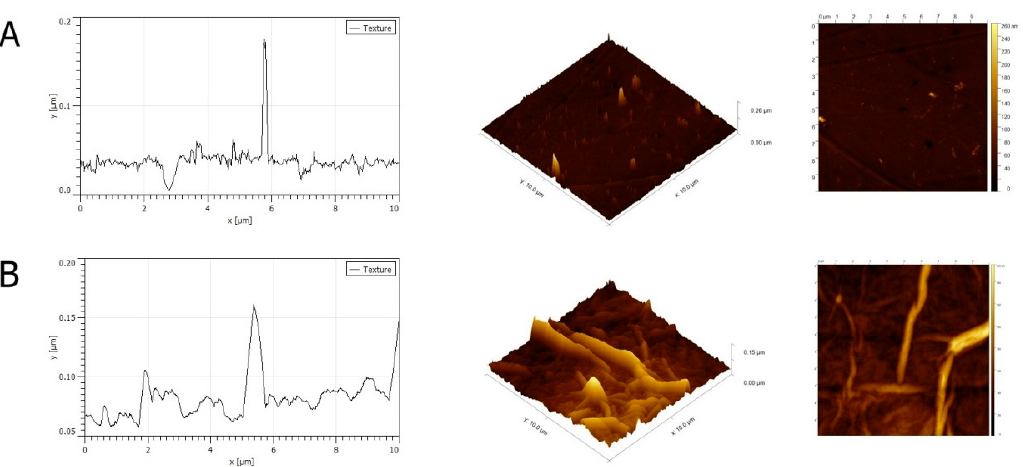
Figure 2. Atomic Force Microscopy (AFM) mages and a topography model of the surface of a culture plate ( A ) and graphene oxide nanofilm ( B ).